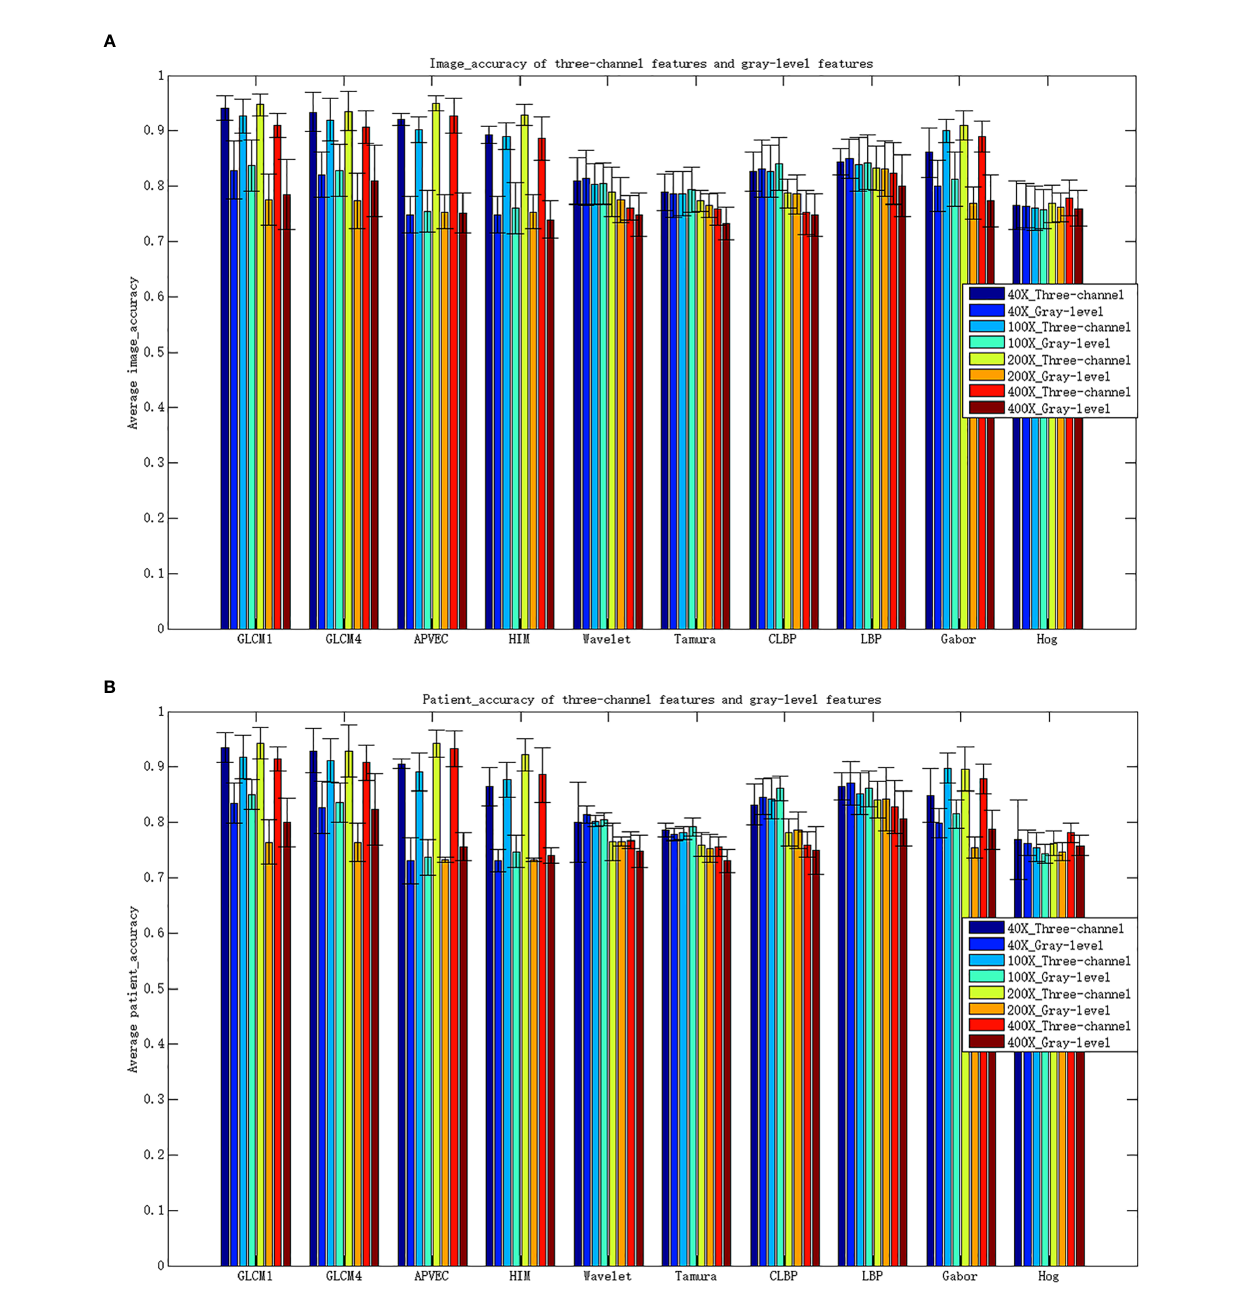
FIGURE 4 | Classi fi cation accuracy for different features. (A) Image_accuracy for three-channel features and gray-level features, (B) patient_accuracy for three- channel features and gray-level